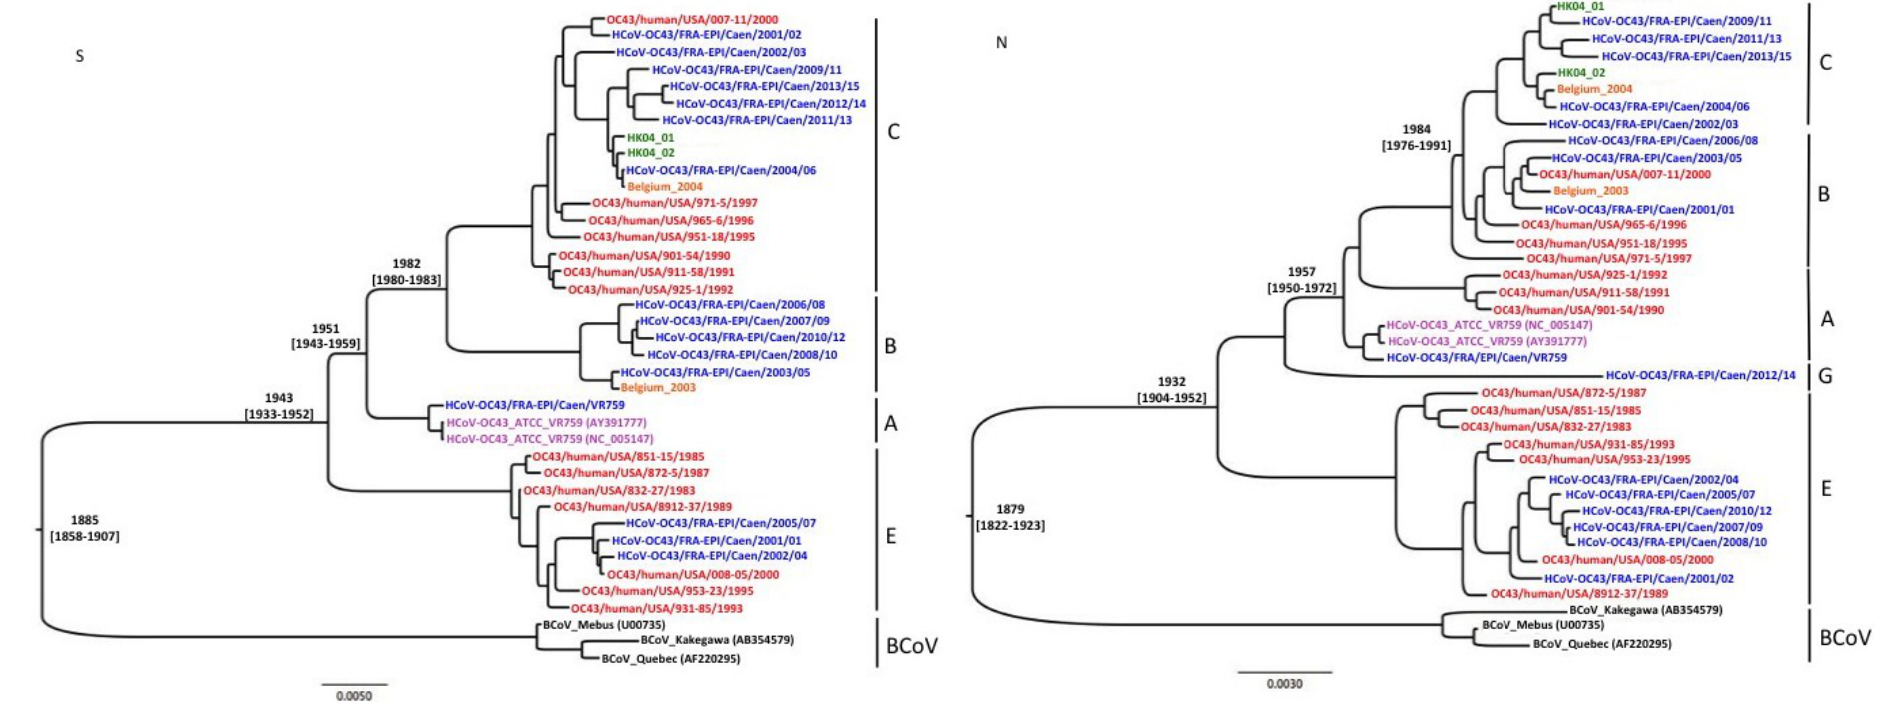
Figure 2. Results of Bayesian analysis based on S and N gene sequence data. Inferences were calculated with the one parametric coalescent model with a constant size, under the TN93+G substitution parameter, using the BEAST package (version 1.8.2) [42]. The length of MCMC was fixed at 10 8 states for S and N genes. The dates of emergence of mean clusters are indicated, associated with the 95%